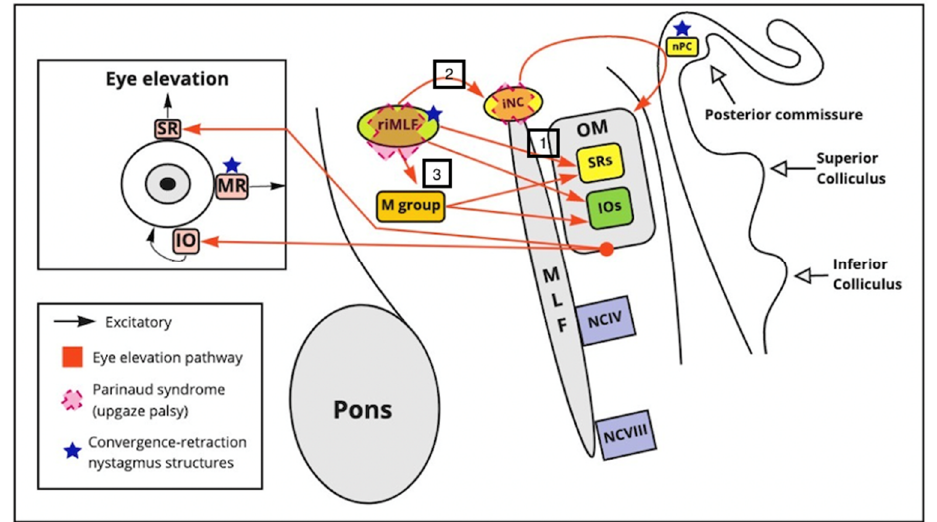
Figure 1. CRN and upward gaze palsy. The superior rectus (SR) and inferior oblique muscle iOM are key for the vertical elevation of the gaze and the oculomotor (OM) nucleus. The riMLF sends information to three destinations: (1) directly to the (SR) and inferior oblique muscle (IOs), (2) to the iNC, which send their axons to the nPC (nucleus of the posterior commissure, (3) to the M group, and CCN which also innervate the RM and iOM nuclei, assisting with upward gaze. CRN is caused by a dysfunction in the riMLF and the nPC, the riMLF receives afferent projections for the center of vergence and convergence. The center of convergence, divergence is located dorsolateral to the oculomotor nerve in the dorsal